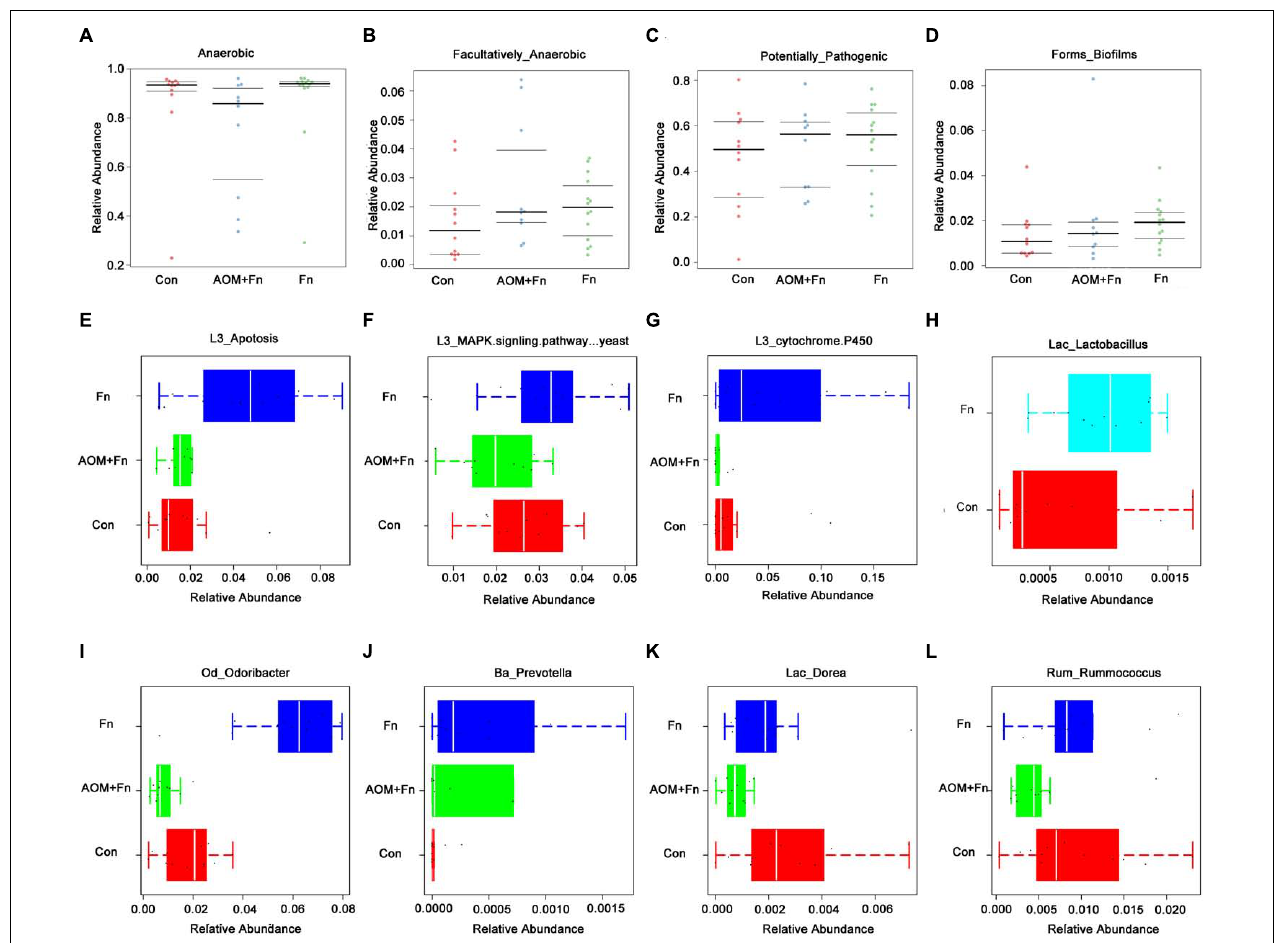
FIGURE 6 | Sequencing analysis of the fecal samples from mice given Fn gavage. (A–G) The relative abundances of genera related to different KEGG functions in the Fn group and control group; (H) distribution of Lactobacillus in the Fn group and control group; (I–L) bacteria with statistical difference in expression between the Fn group, Fn + AOM group and control